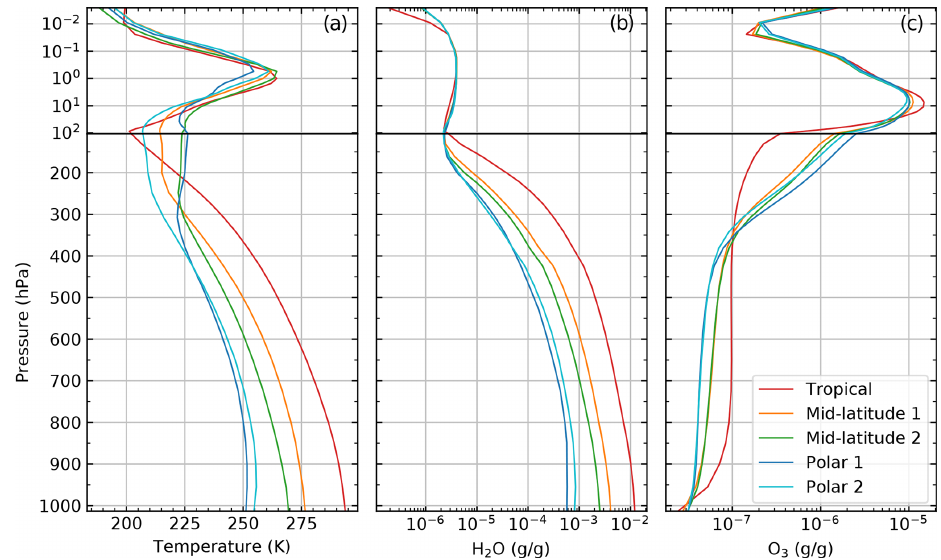
Figure 3. Average atmospheric profiles of temperature (a) , water vapor concentration (b) , and ozone concentration (c) of the mean atmo- sphere of each of the five classes of TIGR. The temperature profile is presented on a linear scale, whereas the concentration profiles are presented on a logarithmic scale in units of grams of gas per gram of dry air. The upper panels present the profiles on a logarithmic pressure scale, and the lower panels present them on a linear pressure scale.